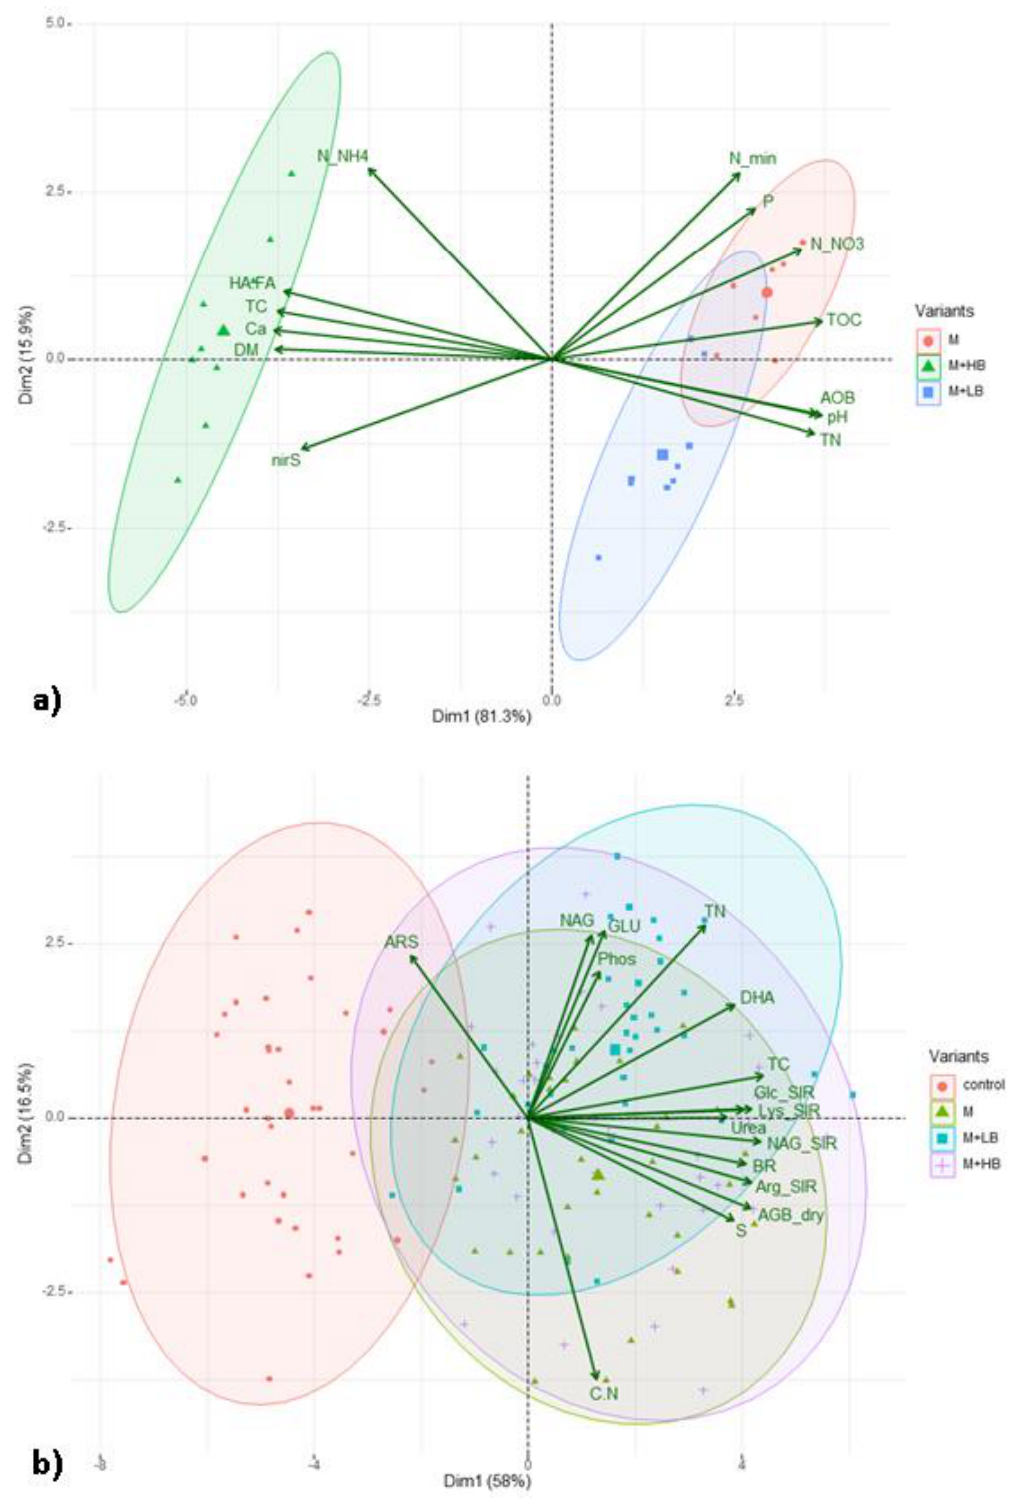
Figure A2. The Rohlf’s PCA biplot of ( a ) matured manure properties and ( b ) soil and plant properties. ( a ) M = manure, M + LB = manure + biochar low dose, M + HB = manure + biochar high dose; ( b ) control = unamended soil, M = soil amended with manure, M + LB = soil amended with manure + biochar low dose, M + HB = soil amended with manure + biochar high dose; position of points/arrows is placed on the basis of their role in the first and second component (Dim1 and Dim2); arrow length equals the rate of property effect.